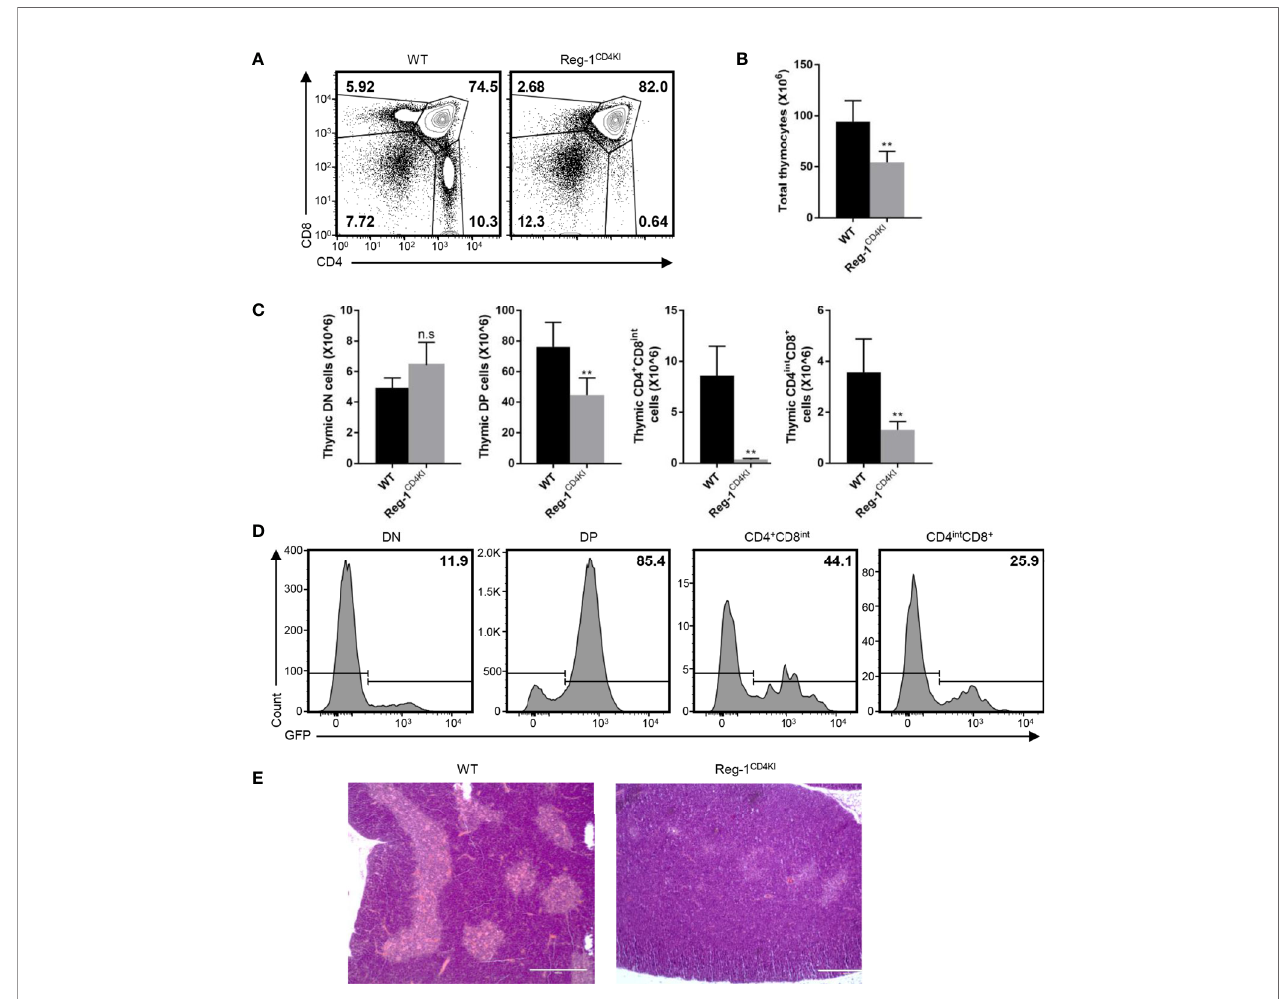
FIGURE 5 | Defective T cell development in Reg-1 CD4KI mice. (A) Surface staining of CD4 and CD8 on WT or Reg-1 CD4KI thymocytes, gated on CD45 + alive cells. (B) Bar graphs representing the number of total thymocyte in WT or Reg-1 CD4KI mice. (C) Bar graphs representing the number of DN, DP, CD4 + CD8 int or CD4 int CD8 + thymocyte subpopulations. (D) The percentage of GFP + cells in DN, DP, CD4 + CD8 int or CD4 int CD8 + thymocytes subpopulations in Reg-1 CD4KI mice. (E) Representative H&E staining images (×100) of thymus from WT or Reg-1 CD4KI mice. The cortex (darker) and medulla (lighter) can be distinguished by the intensity of staining. Data are mean ± SD (n=5) from one experiment, representative of three independent experiments. n.s not signi fi cant; ** P < 0.01 (unpaired two-tailed Student ’ s t